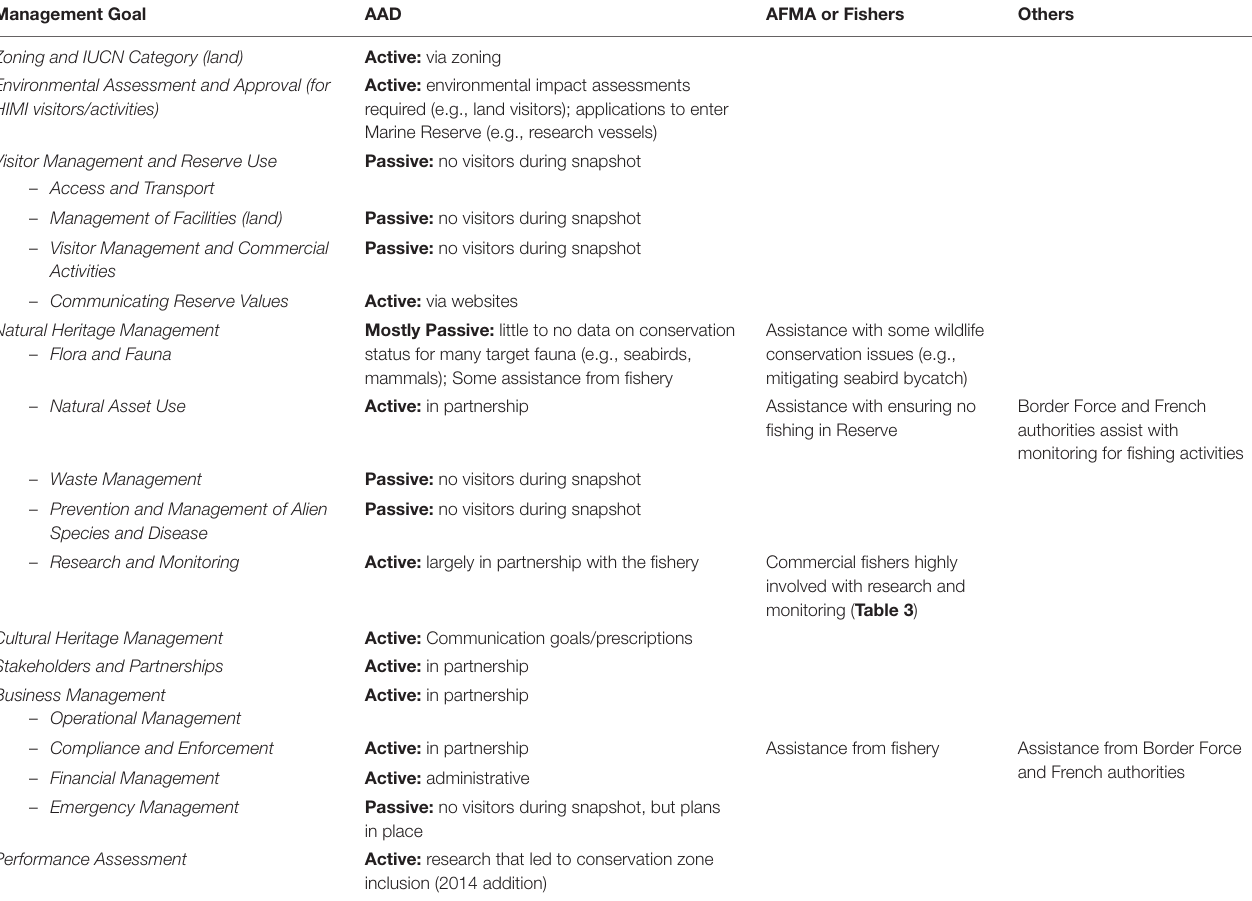
TABLE 2 | Collaboration toward meeting primary management goals. Management